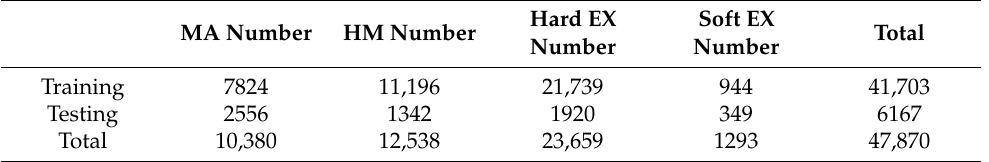
Table 4. The annotated lesions distribution in the DDR